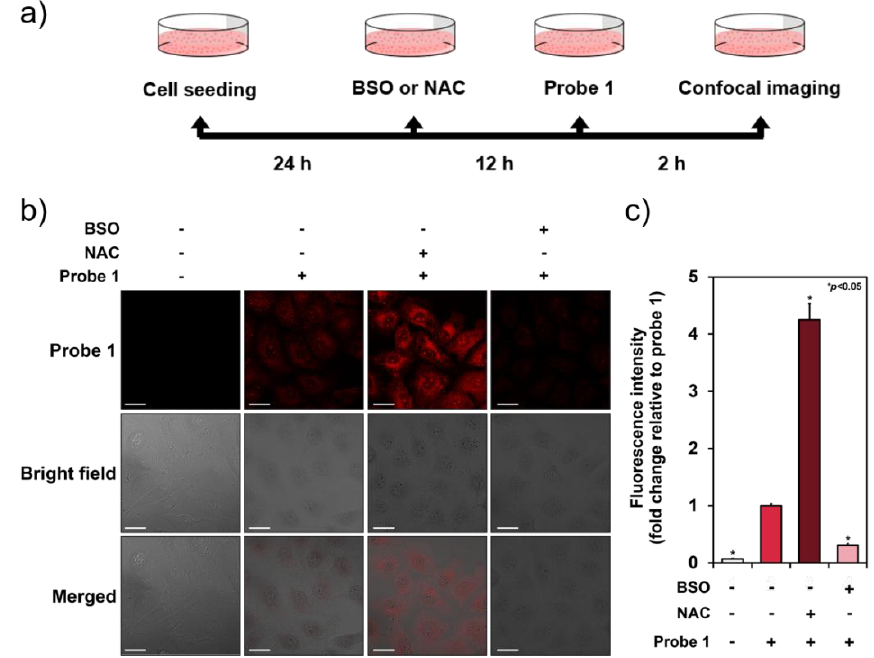
Figure 6. Confocal laser scanning microscopy images of 1 in MDA-MB-231 cells. ( a ) Preparation of cells for the confocal imaging using probe 1 , buthionine sulfoximine (BSO), and N -acetyl- L -cysteine (NAC); ( b ) cells were pretreated with BSO (100 µM; GSH inhibitor) or NAC (3 mM; ROS scavenger) for 12 h and then incubated with 1 (10 µM) for 2 h. Scale bar = 20 μm; ( c ) the relative fluorescence intensity (fold change) of probe 1 was presented. The mean values of each group were quantified in 40 cells per treatment condition, after setting a common threshold for all images using Image J. Data are represented as fold change vs. the indicated reagents. The deep red bar indicated a fluorescence increase after NAC treatment, whereas pink bar represented a fluorescence decrease after BSO treatment. The percent fold changes are all significant (* p < 0.05) based on a t -test.